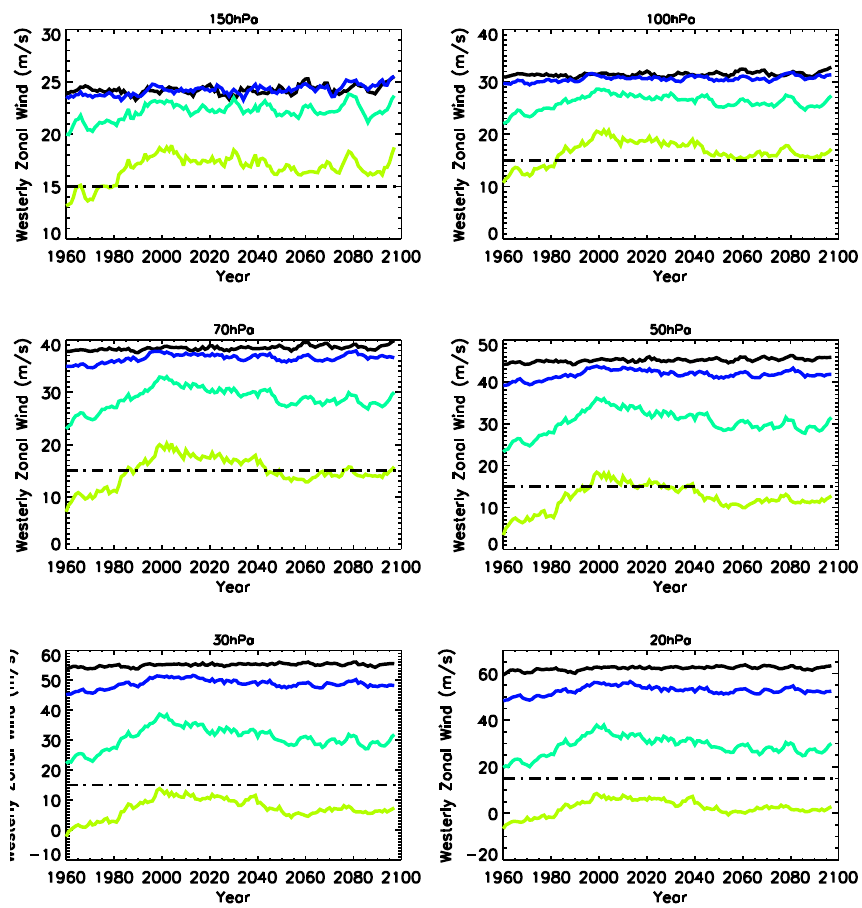
Figure 7. Time series of monthly zonal mean zonal wind speed averaged across 50º-70ºS at 20-150 hPa. Dot-dashed lines indicate the minimum wind velocity of 15 m/s that identifies the polar vortex edge. Colors correspond to same months as in Figure 5.